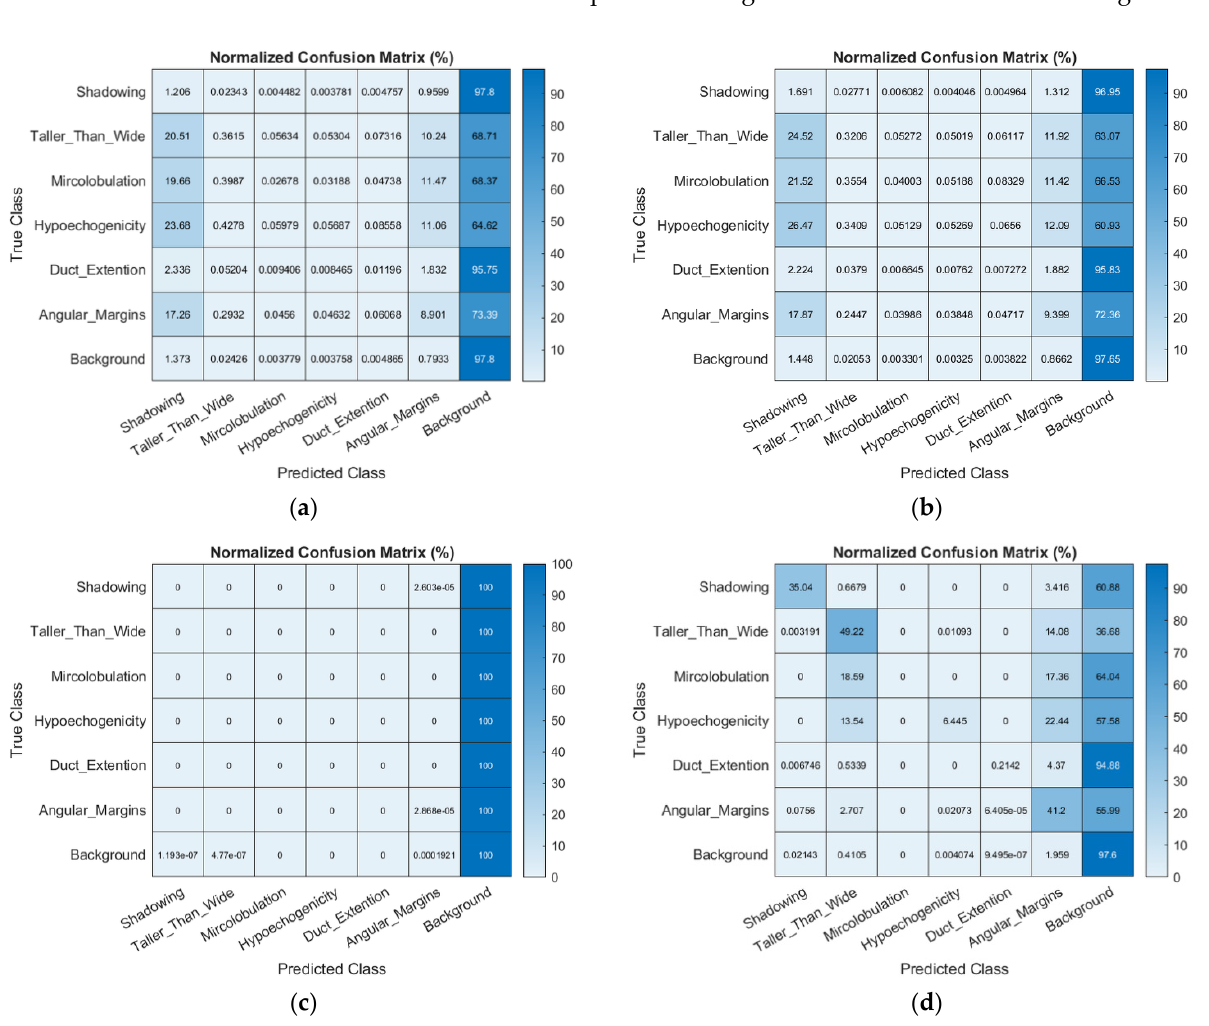
Figure 7. Normalized Confusion Matrix of the classification performance based on selected BI-RADS lexicons in SegNet, U-Net, and FCN-32s. The proportion of correctly recognized in each lexicon among the three networks (in percentage). ( a ) classification performance of SegNet with the VGG16 encoder; ( b ) classification performance of SegNet with the VGG16 encoder; ( c ) classification performance of U-Net; ( d ) classification performance of the FCN.